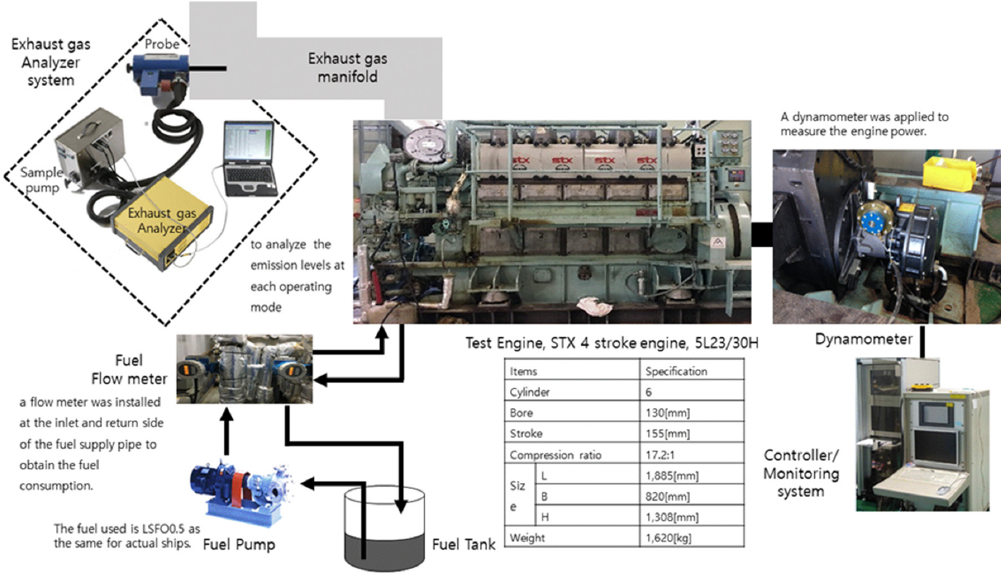
Figure 11. Configuration of test bed.